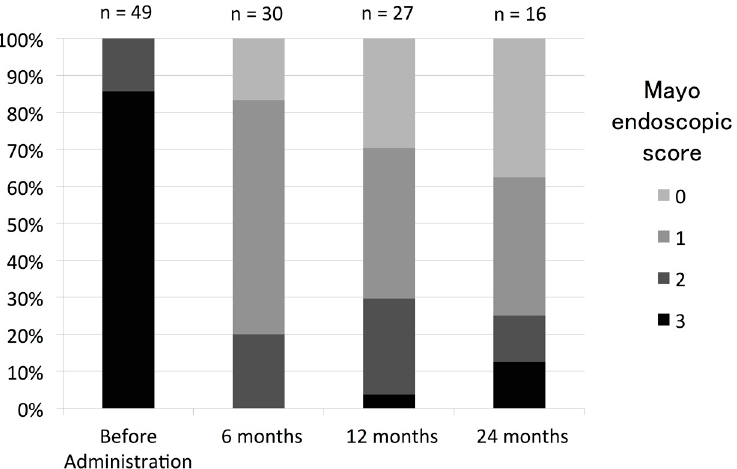
Figure 3. Endoscopic evaluation of patients treated with tacrolimus. Endoscopic severity was assessed by endoscopic-activity index before tacrolimus therapy, and 6, 12, and 24 months after administration.